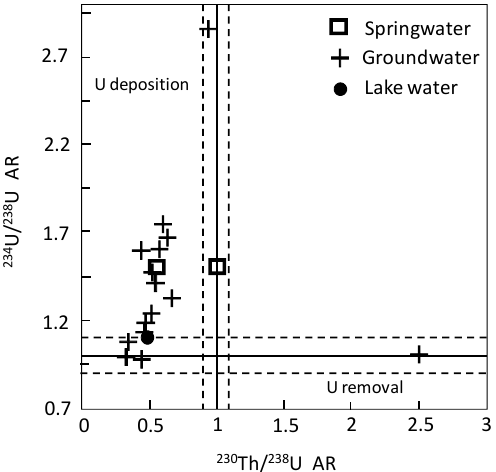
Figure 3. Thiel diagram of U decay series for waters from the Shihongtan U ore district. Most samples plot in the U deposition region. Solid lines represent secular equilibrium and the dashed lines define error limits. Data from Table 1.